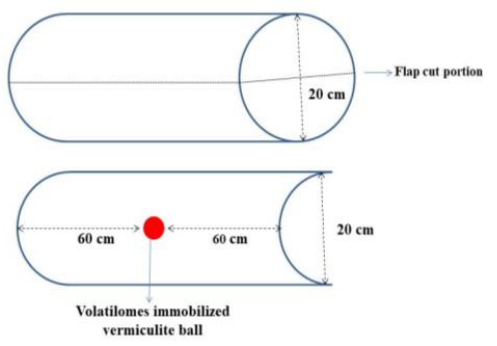
Figure 9. Model of PVC Pipe Chamber at different lengths.